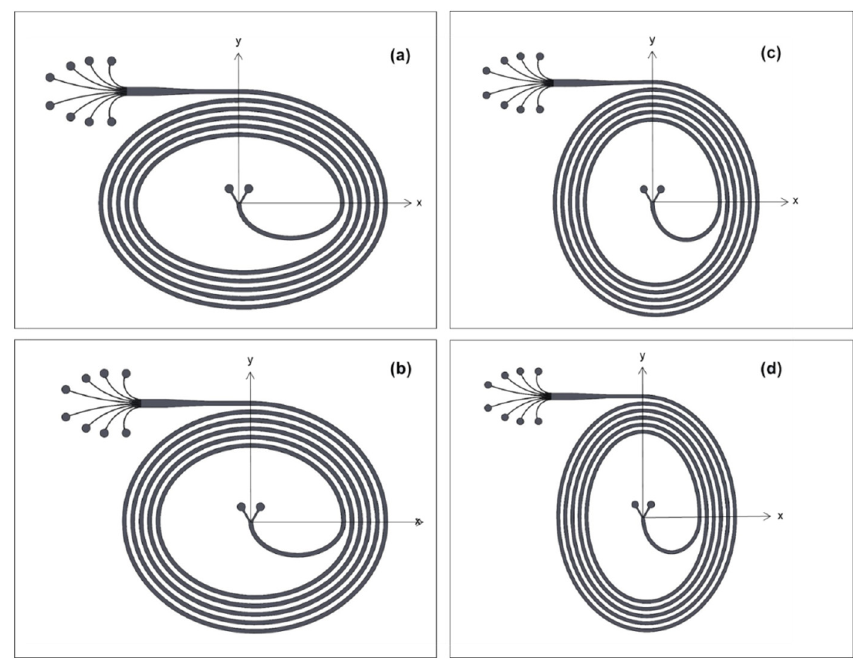
Figure 2. Schematics of the elliptic spiral microchannels: ( a ) Case 1 (initial aspect ratio (IAR): 3:2), ( b ) ( b ) Case 2 (IAR: 11:9), ( c ) Case 3 (IAR: 9:11) and ( d ) Case 4 (IAR: 2:3). Case 2 (IAR: 11:9), ( c ) Case 3 (IAR: 9:11) and ( d ) Case 4 (IAR: 2:3).